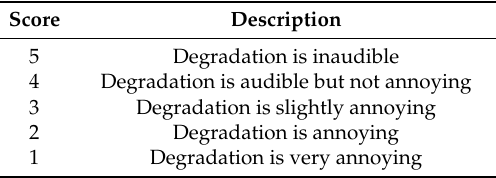
Table 2. Score and description of degraded mean opinion score (DMOS) assessment.